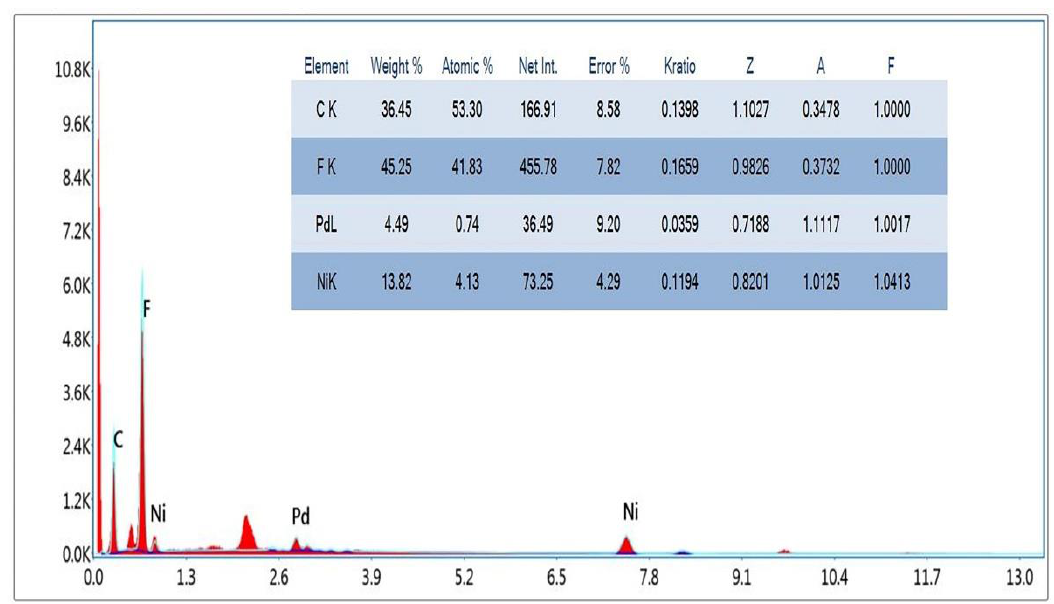
Figure 2. EDX of Ni 75 Pd 25 @PVDF-HFP NFs membrane. The inset shows the percentage weight of the elements.